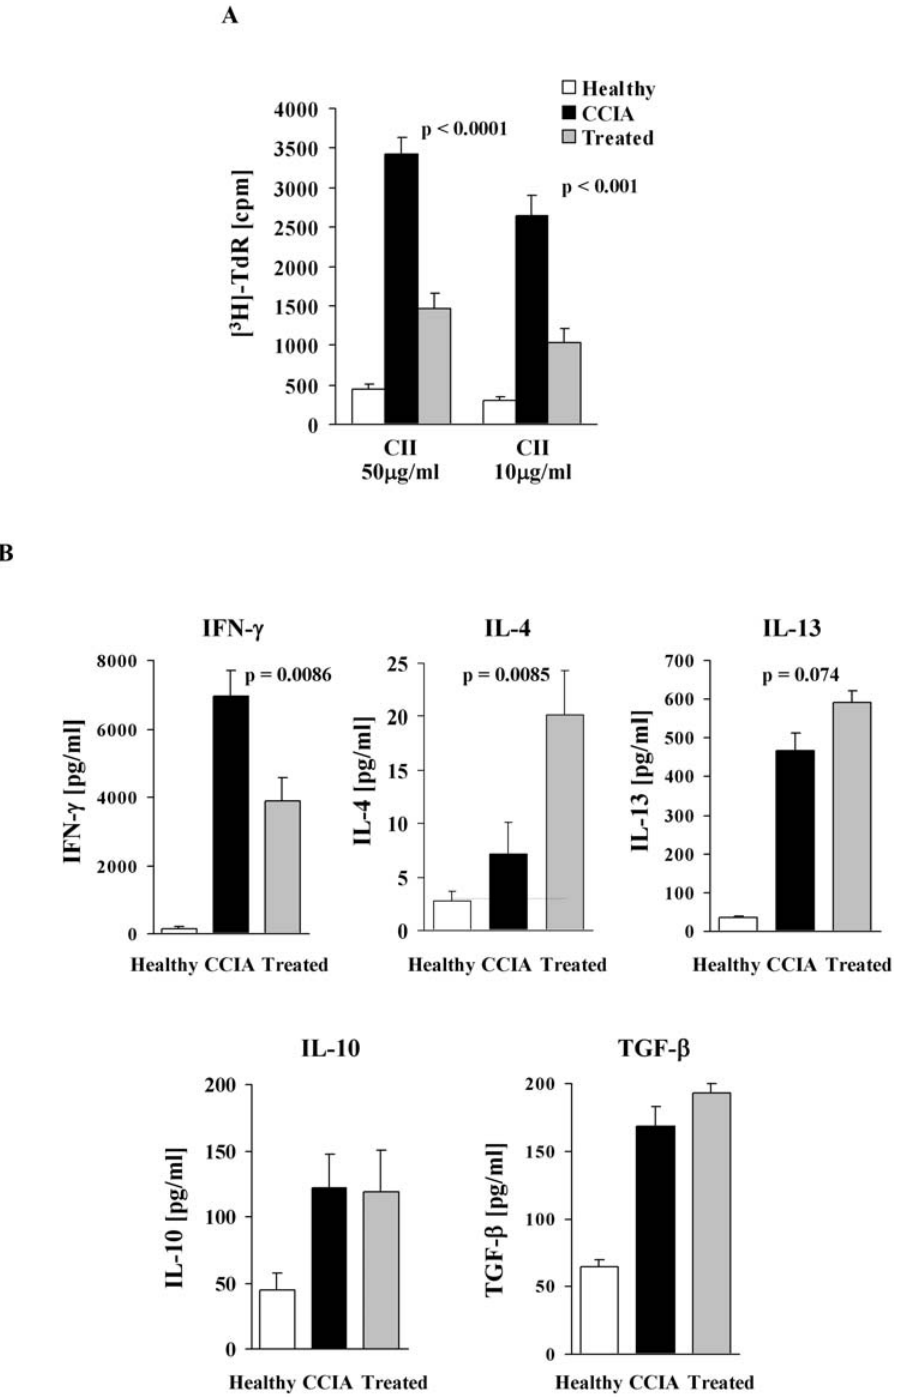
Figure 3. Epicutaneous immunization inhibits CII-specific proliferation, reduces Th1 and enhances Th2-type cytokines. Splenocytes were collected from each mouse and cultured for 90 h with CII or control antigen. Proliferation was determined by [ 3 H]-thymidine incorporation (A) and cytokine production by ELISA (B). Results of proliferative experiments are expressed as mean cpm + 1 SEM (n=9). Background proliferation when no antigen was present has been subtracted. No proliferation was observed to control antigen but the two groups responded with similar [cpm] when stimulated with ConA. Production of IFN- c , IL-4, IL-13, IL-10 and TGF- b is expressed as mean pg/ml + 1 SEM (n=9). No cytokines were produced in response to a control antigen or when cells were not stimulated. Dashed horizontal lines (where visible) represents limit of detection. ( % )=un- immunized healthy controls, ( & )=treated with epicutaneous CII, ( & )=sham-treated CCIA controls.